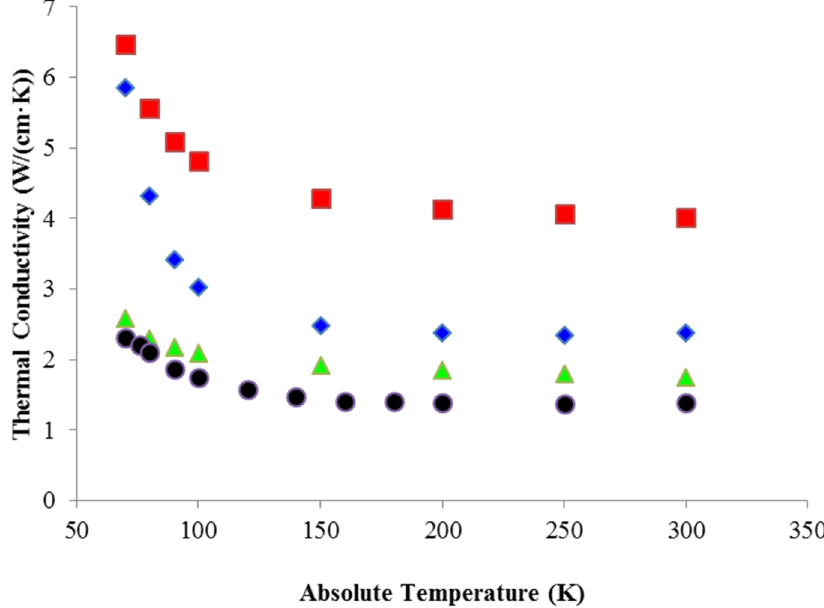
Figure 19. Thermal conductivity as a function of absolute temperature for the elemental metals copper (red [56]), titanium (green [56]), molybdenum (black [57]), and aluminum (blue [56]).